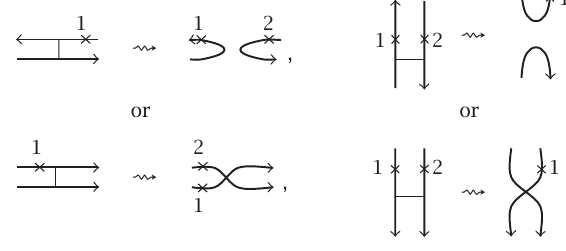
Figure 7.8 . Descriptions of W ob